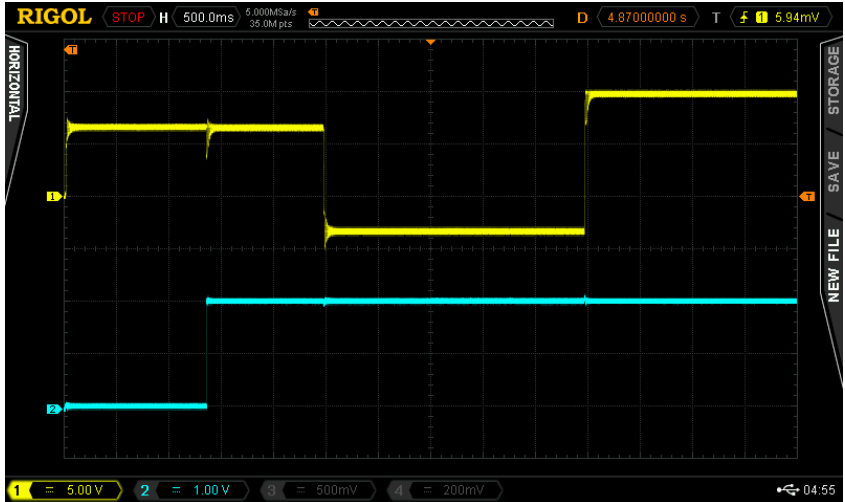
Figure 9. Speed (yellow, x -axis: 400 ms/div, y -axis: 150 rpm/div) and torque (blue, x -axis: 400 ms/div, y -axis: 1 Nm/div) of the BLDC motor in experimental test.